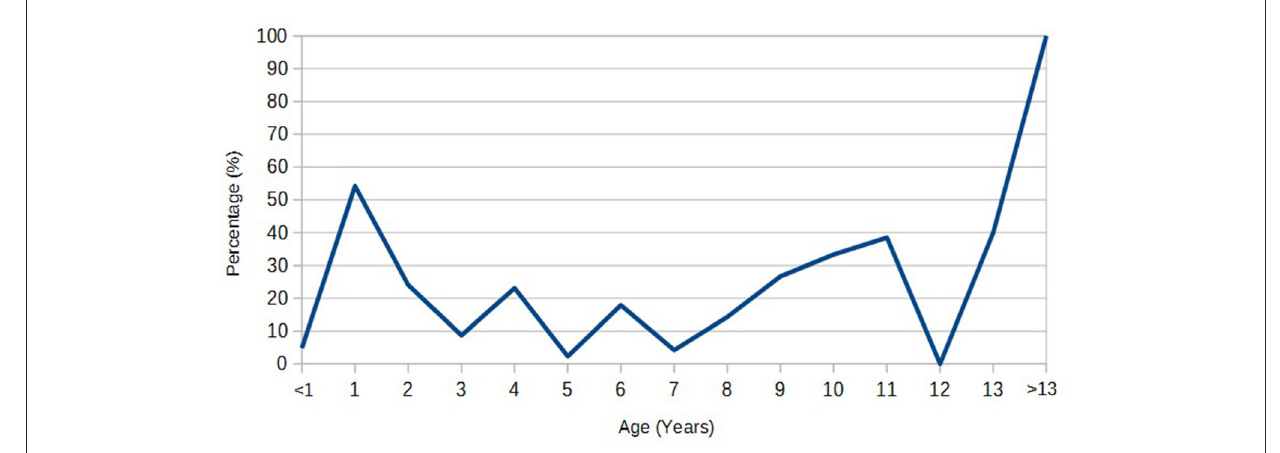
FIGURE1 Seroprevalence according to